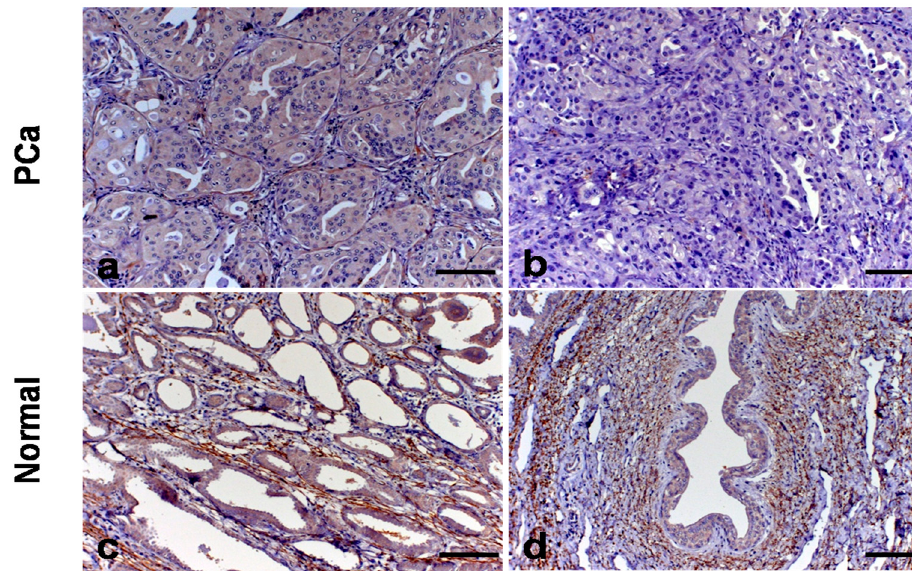
Coll-I: Collagen I, Coll-III: Collagen III, N: Normal, PC: Prostate cancer.